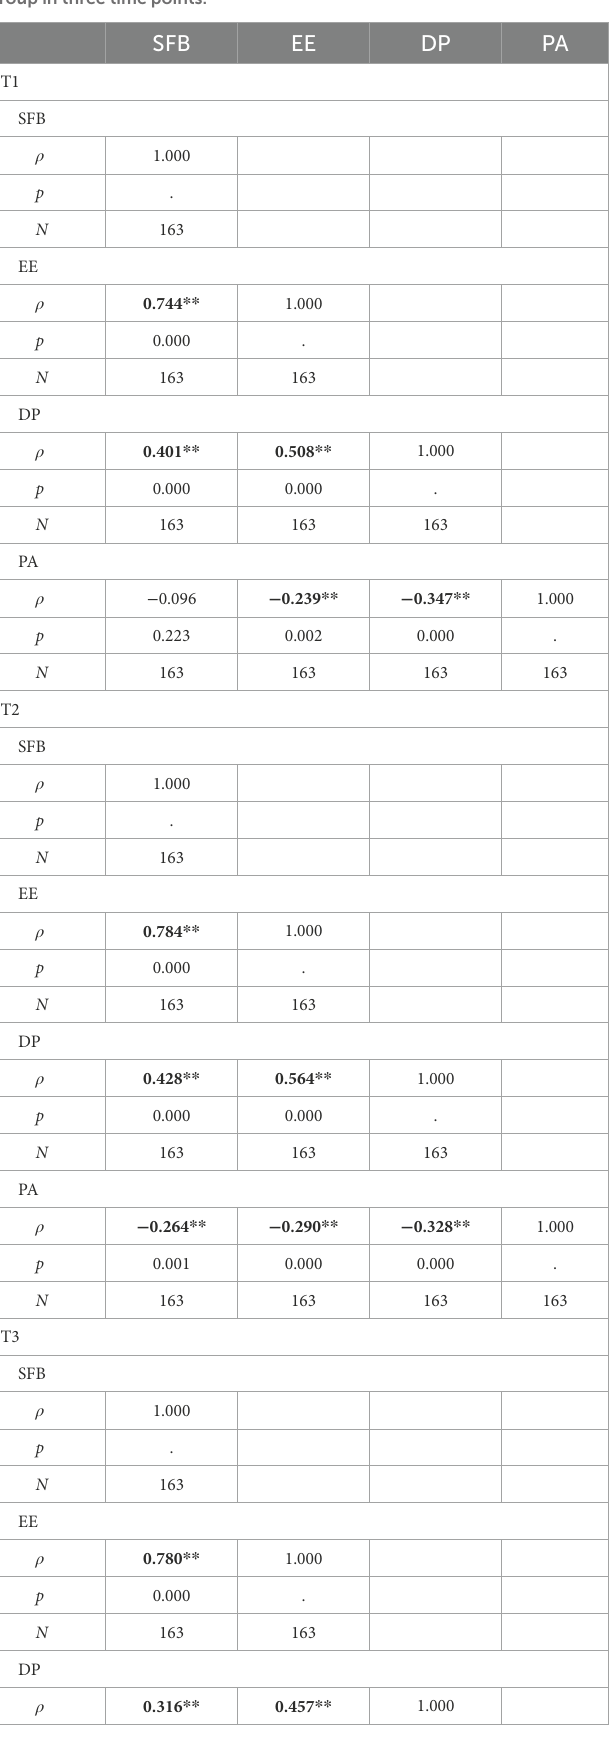
TABLE 4 Correlation analysis of burnout dimensions and SFB for panel group in three time points.